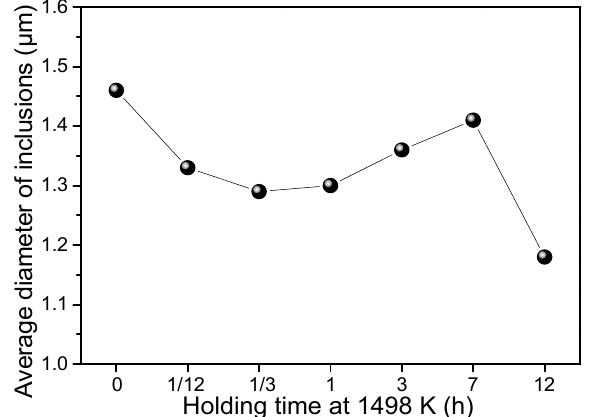
Figure 9. Variation in the number density of inclusions in the steel during heat treatment at 1498 K.